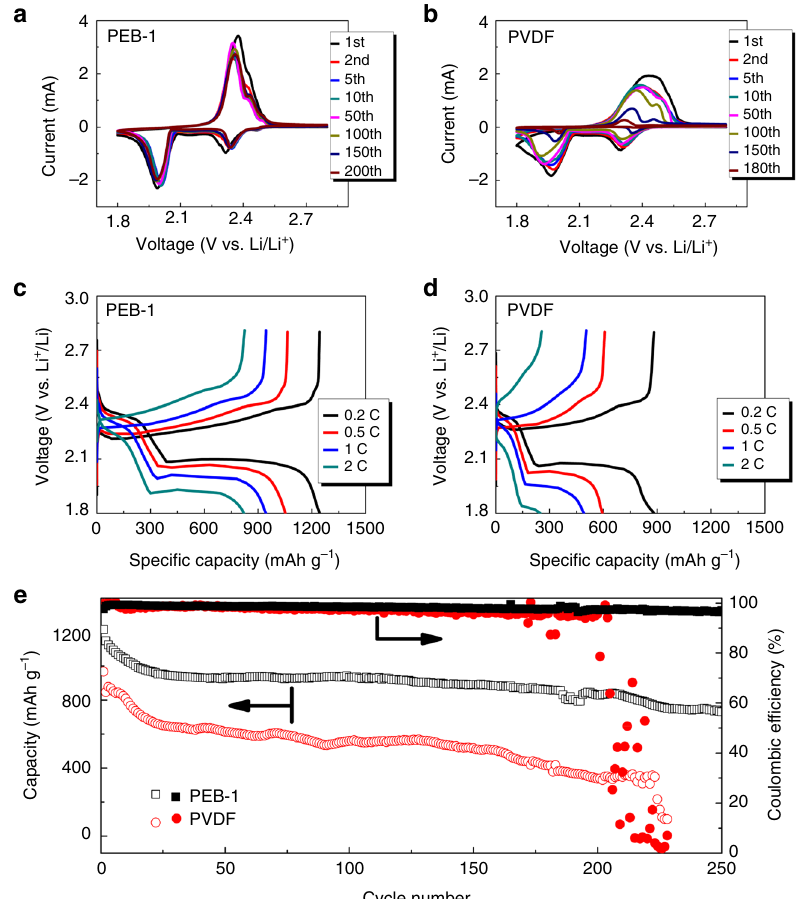
Fig. 4 Electrochemical performance of Li – S full cells with PEB-1 or PVDF binder. a , b Long-term cyclic voltammetry (CV). c , d Discharge and charge curves at different C rates. e Cycling performance for each cell type at a rate of C/5. In all cases, the composite sulfur electrode was cast onto an